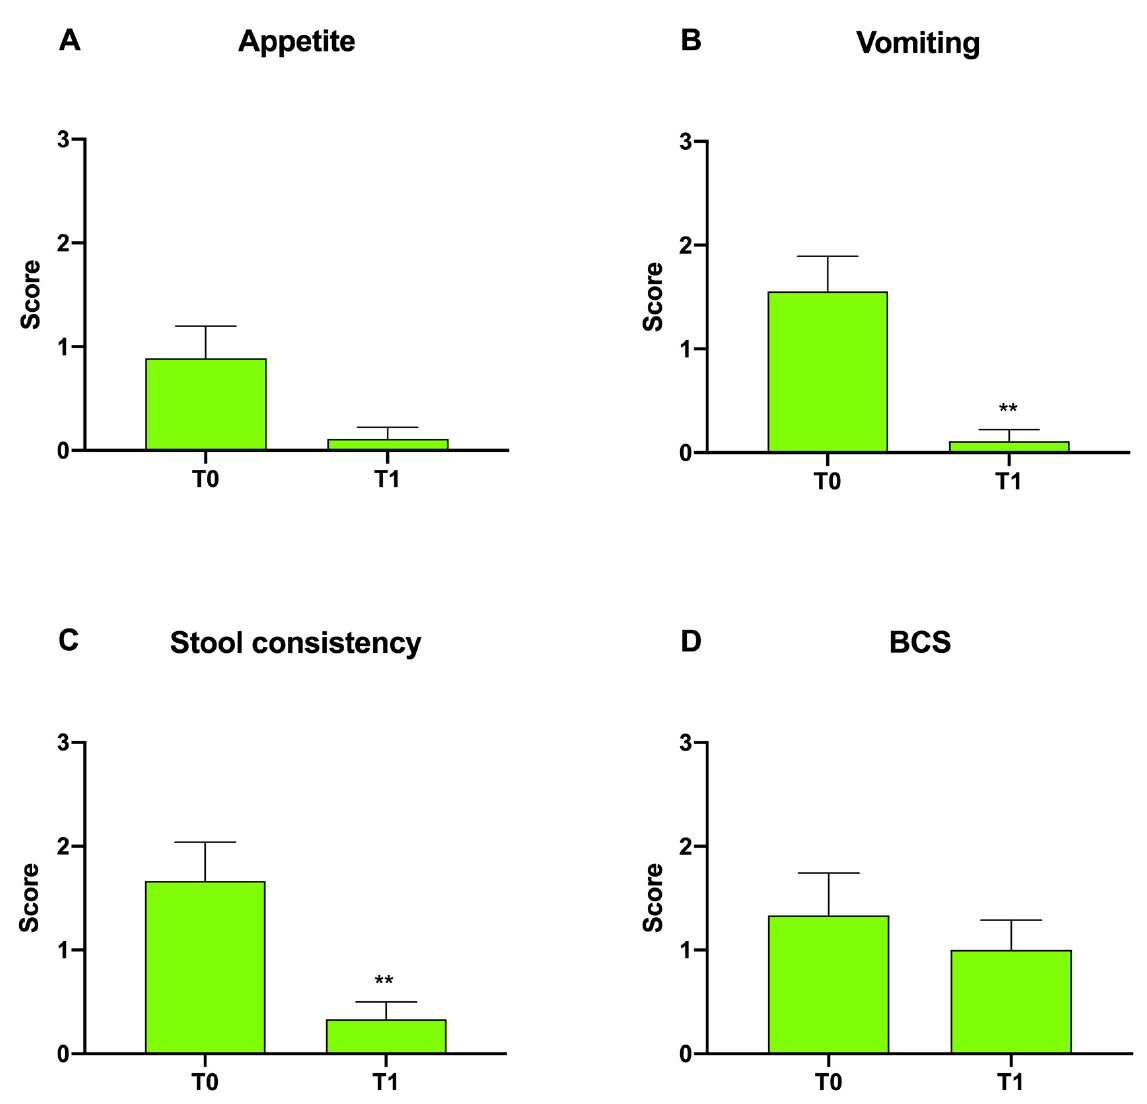
Figure 2. Graphical representation of the appetite ( A ), vomiting ( B ), stool consistency ( C ) and BCS ( D ) modified FCEAI score within both Group B at T0 vs. T1 following probiotic administration (** p < 0.01).